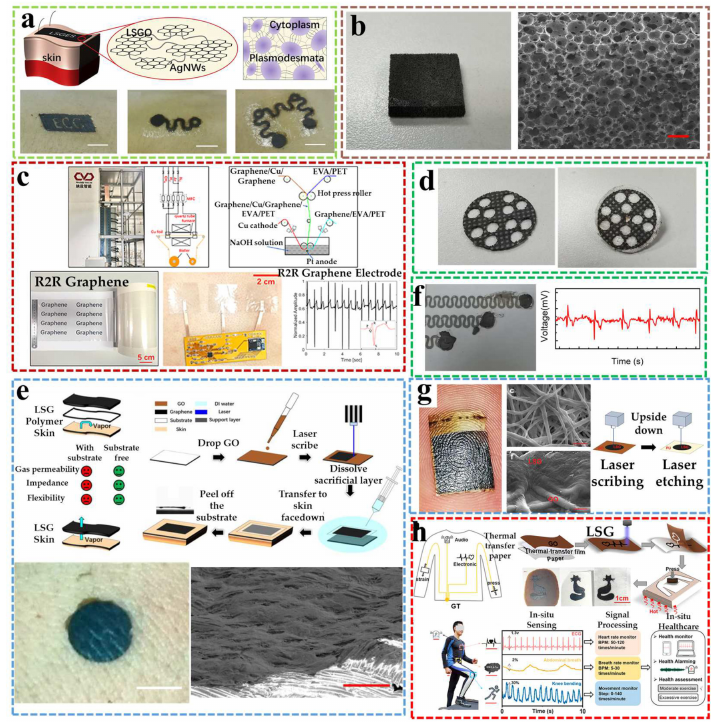
Figure 6. ( a ) Electrode based on silver nanowire bridging graphene. Reprinted with permission from Ref. [89]. Copyright 2020, Elsevier. ( b ) Styrene–butadiene foam/graphene ECG electrode ( left ) and its SEM image ( right ), scale bar: 300 µ m. ( c ) The production of roll-to-roll graphene films and their application in ECG electrodes. Reprinted with permission from Ref. [15]. Copyright 2021, IOPscience. ( d ) The recycled non-woven fabric/graphene ECG electrode. ( e ) The fabrication process, photo, and SEM image of the substrate-free graphene electrode; scale bar: 200 µ m. Reprinted with permission from Ref. [26]. Copyright 2020, American Chemical Society. ( f ) The spray-coated nanofiber-based graphene ECG electrode and acquired ECG signal. ( g ) The intelligent graphene nanomesh electrode. Reprinted with permission from Ref. [18]. Copyright 2022, Wiley. ( h ) The graphene-based multifunctional clothing for daily healthcare. Reprinted with permission from Ref. [93]. Copyright 2021, American Chemical